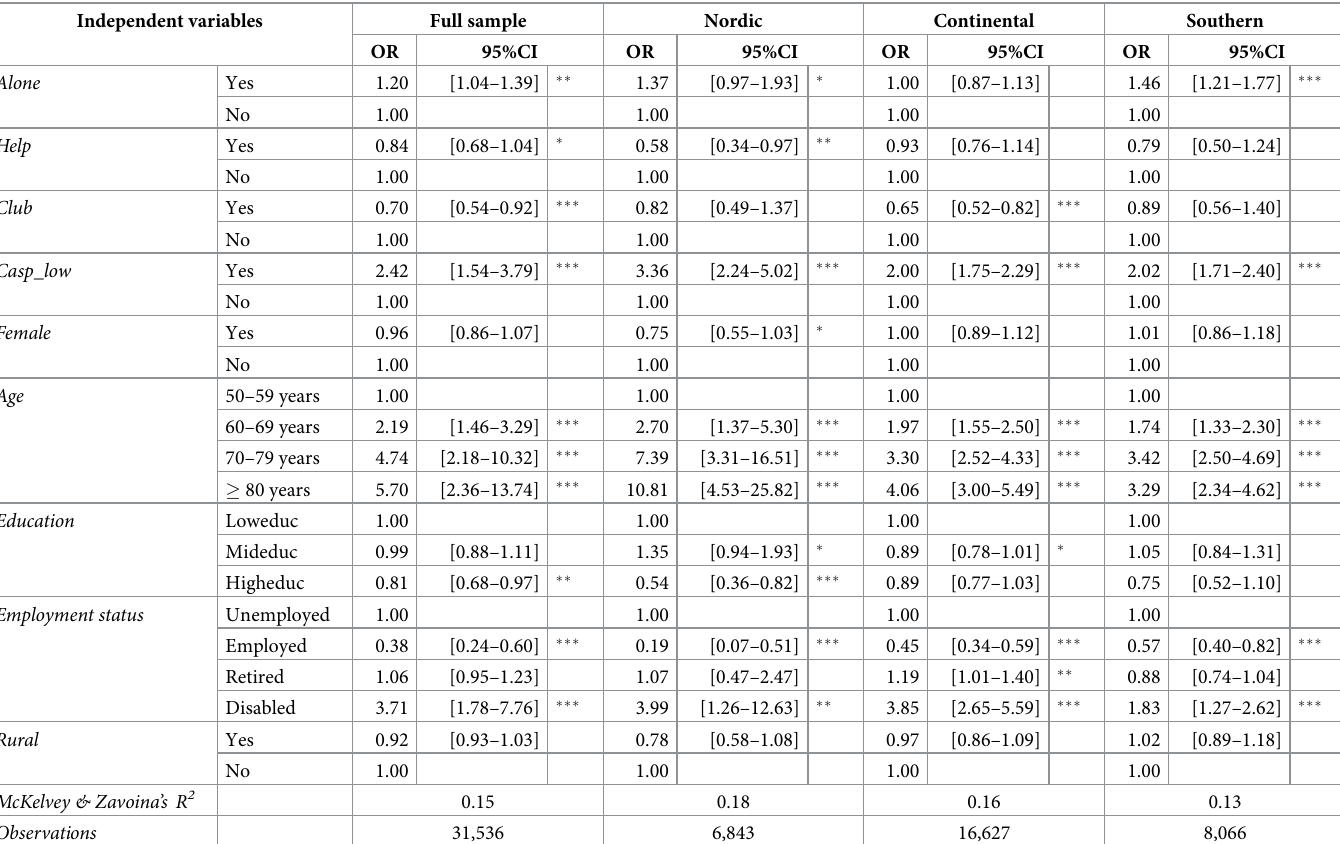
Table 4. Associations of social isolation, socio-demographic variables and chronic illnesses: logistic regressions models (odds ratios and 95% confidence